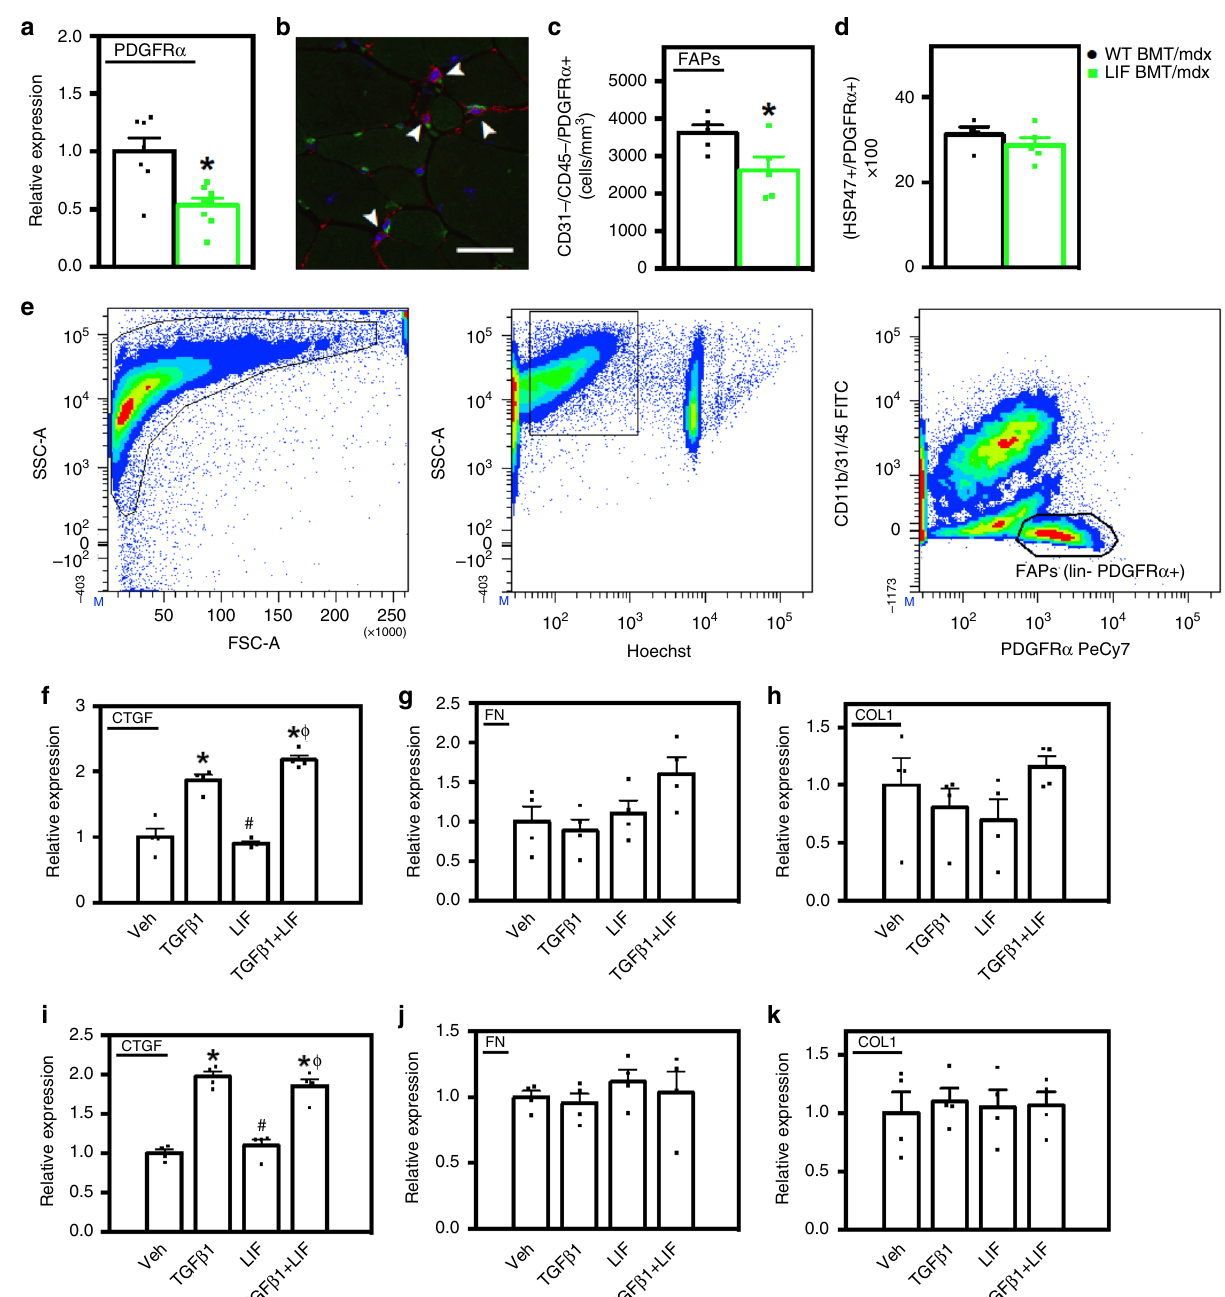
Fig. 8 Transplantation of CD11b/LIF transgenic BMCs reduces the numbers of FAPs in dystrophic muscle but does not affect phenotype. a QPCR analysis shows that TA muscles from LIF BMT/ mdx recipients have reduced Pdgfra gene expression. N = 7 or 8 for WT BMT/ mdx and LIF BMT/ mdx data sets, respectively, * indicates signi fi cantly different from WT BMT/ mdx recipients at P < 0.05. P- values based on two-tailed t- test. For all histograms in the fi gure, the bars indicate mean ± sem. b To quantify the number of FAPs, muscle sections were co-labeled with antibodies to PDGFR α (red) and CD31, CD45 (green). Arrowheads indicate FAPs (CD31-CD45-PDGFR α + ). Bar = 50 μ m. c Fewer FAPs (CD31-CD45-PDGFR α + ) in TA cross-sections of LIF BMT/ mdx recipients compared to WT BMT/ mdx recipients. N = 5 for each data set. d There was no detectible change in phenotype of PDGFR α + cells assayed for co-expression of the fi brogenic marker HSP47. e FACS plots demonstrating strategy for sorting FAPs (Hoechst + CD11b-CD31-CD45-PDGFR α + ). Fibroblasts derived from FAPs were stimulated with LIF (10 ng/ml) and/or TGF β 1 (10 ng/ml) for 3 h ( f – h ) or 3 days ( i – k ) and assayed by QPCR for Ctgf ( f , i ), Fn1 ( g , j ), and Col1a1 ( h , k ). N = 4 technical replicates for each data set. Signi fi cant fi ndings were veri fi ed with biological replicates of cells sorted from independent donors. * Indicates signi fi cantly different from control cultures, # indicates signi fi cantly different from TGF β 1 treated cultures, and Φ indicates signi fi cantly different from LIF-treated cultures at P < 0.05. P- values based on ANOVA with Tukey ’ s multiple comparison test. Source data are provided as a Source Data fi